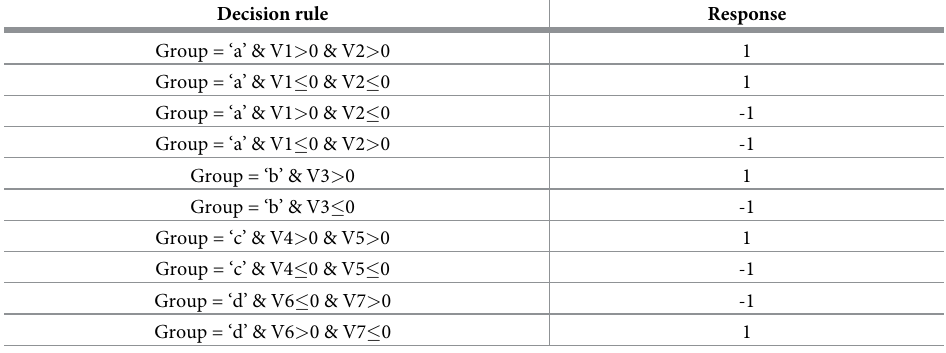
Table 2. Predetermined decision rules to generate the response variable from the simulated